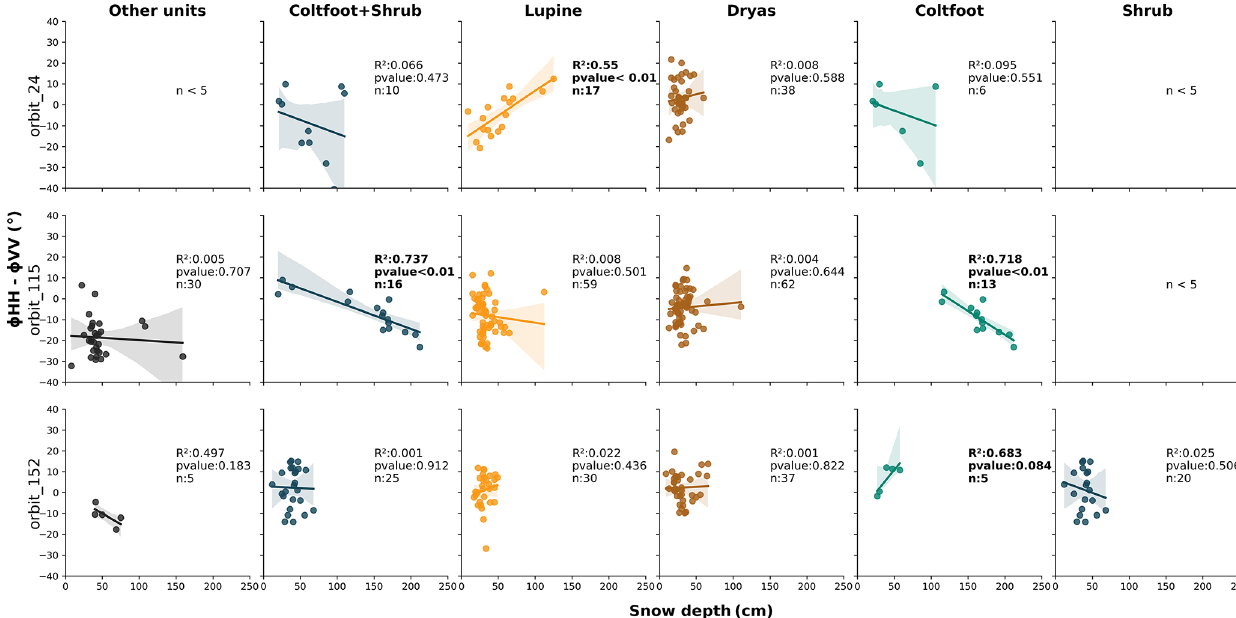
Figure 6. Correlation analysis between CPD and snow